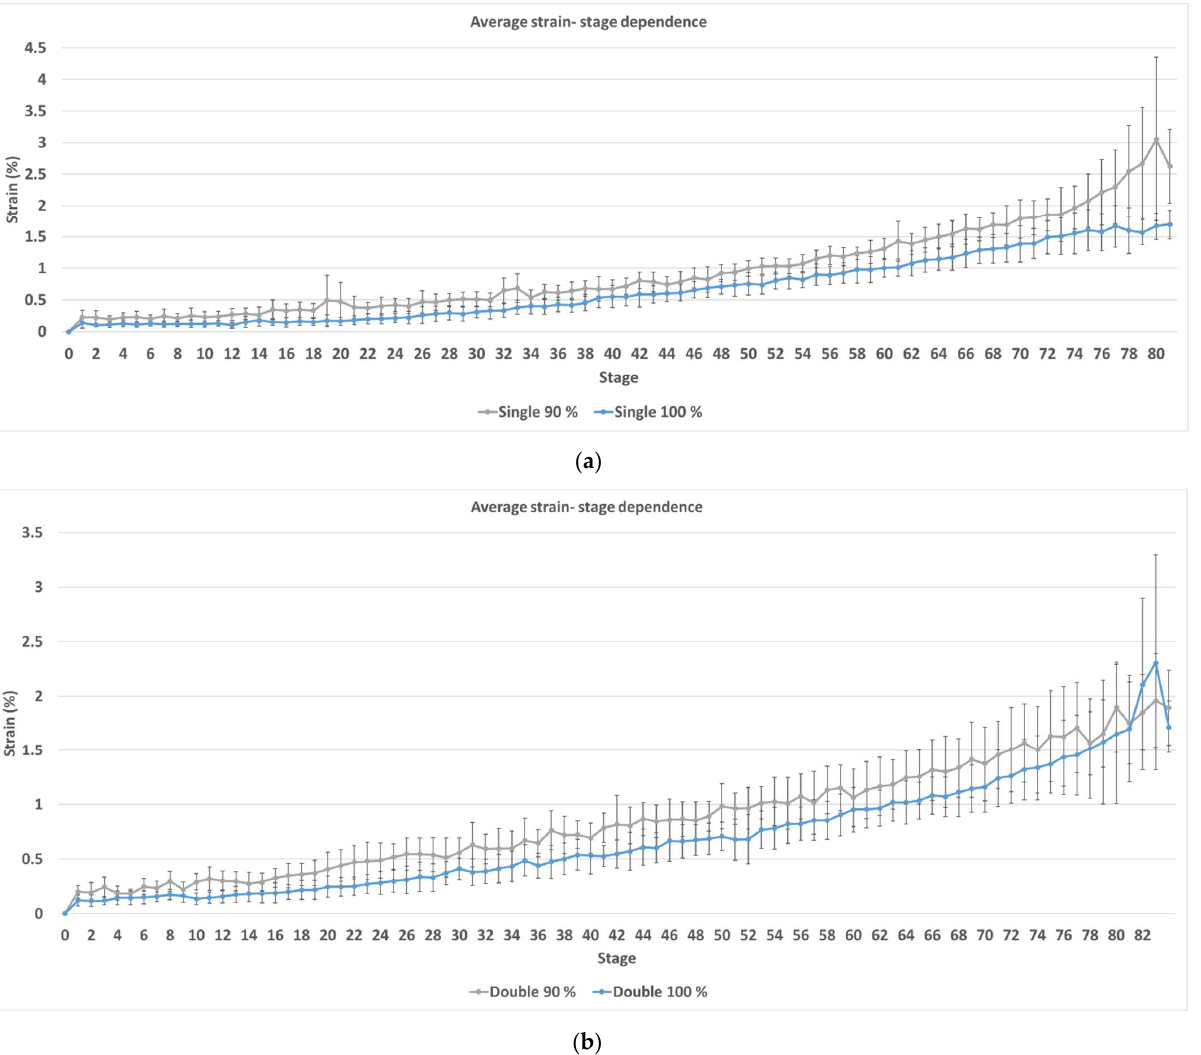
Figure 8. Visualization of average strain-stage dependence for Single and Double PRTS with 90% and 100% infill with standard deviation: ( a ) Single PRTS 90% and 100% infill; ( b ) Double PRTS 90% and 100%.